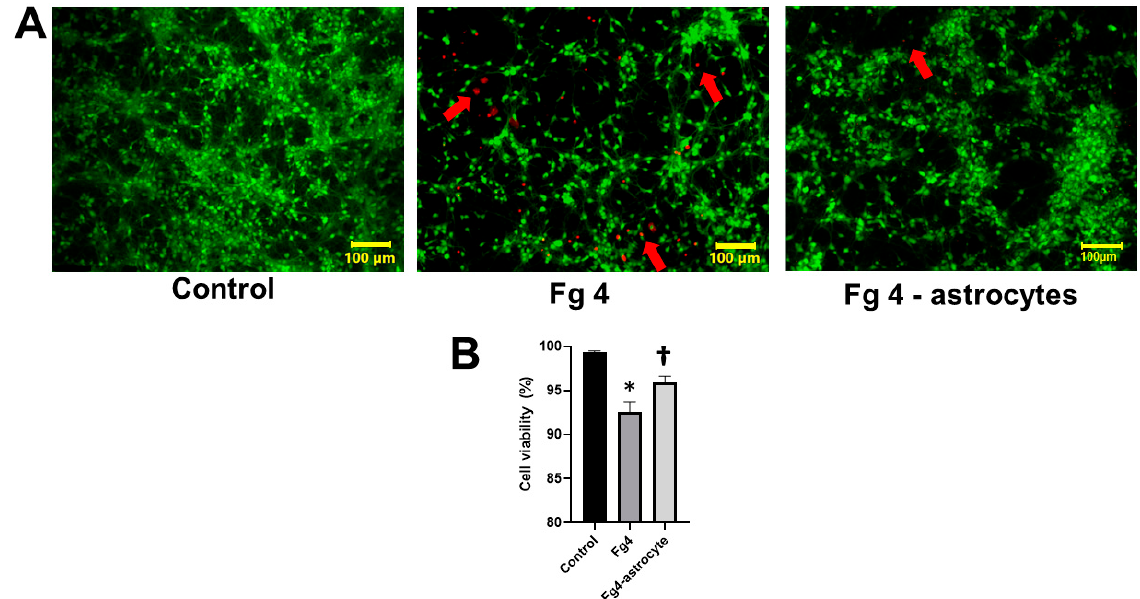
Figure 4. Fibrinogen (Fg)-induced astrocyte activation increased neuronal cell death. ( A ) Representative images show live/dead staining of neurons co-cultured with astrocytes that were treated with 4 mg of Fg (Fg4) or neurons that were left growing on the bottom of the well with 4 mg/mL of Fg on the Transwell ® membrane with no astrocytes (Fg4-astrocytes) for 24 h. Live neurons were detected by uptake and trapping of calcein AM (green fluorescence) while dead cells were the ones that were unable to trap calcein AM and were permeable to ethidium homodimer (red fluorescence). Red arrows indicate dead neurons. ( B ) Summary of image analyses for the detection of live neurons presented as a percent of a total number of neurons. An automatic cell count was performed, based on the fluorescence signal threshold of images provided by the CellSens Dimension software. Well-defined “segments” were counted to define number of dead cells as a percent of a total number of cells in the same image. Data were averaged for each group. p < 0.05; *—vs. Control, †—vs. Fg4; n = 6.